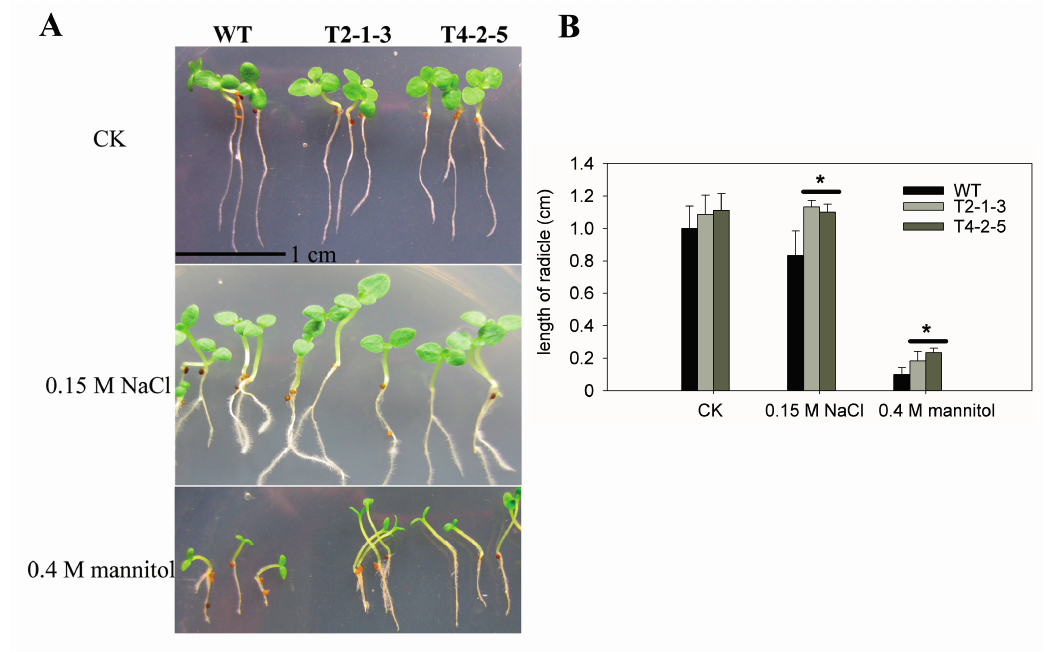
Figure 2. Seedling growth of WT and transgenic lines of T3 tobacco plants subjected to osmotic stress. ( A ) Germinated seedlings with radicles of similar length were cultured in half-strength MS medium supplemented with 0.15 M NaCl or 0.4 M mannitol or control, and photographs were taken after 7 days of incubation; the scale bar represents 1.0 cm; ( B ) Results are the mean ± standard error (SE), replicated thrice. * indicates significant differences when compared with the control at a p value